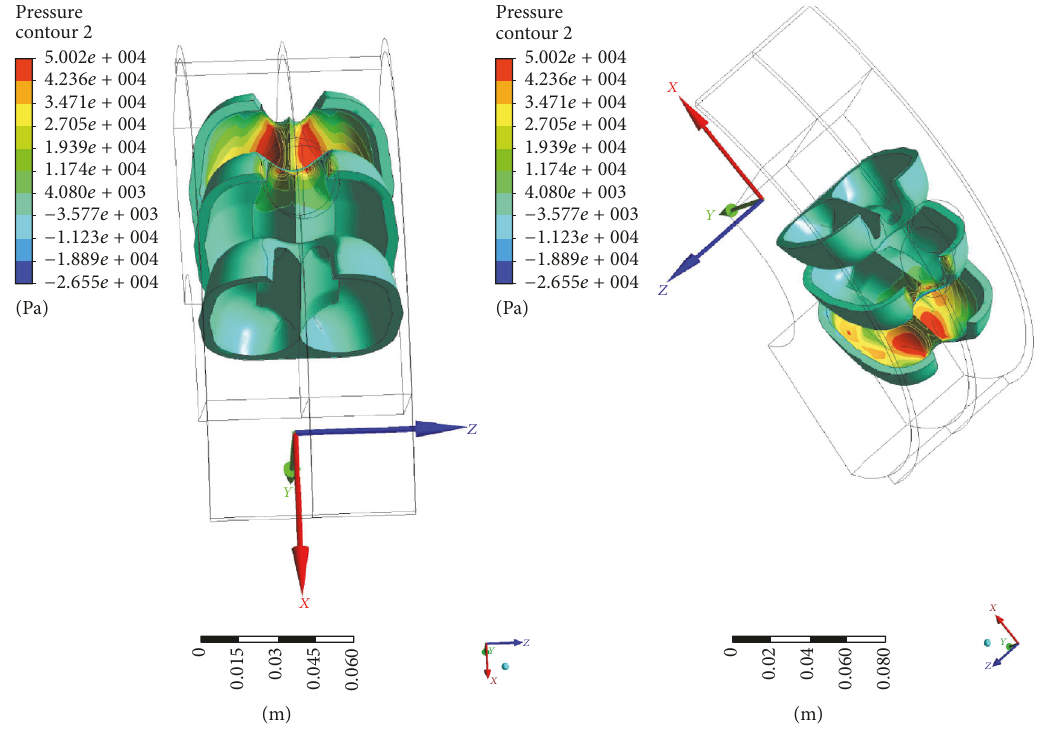
Figure 12: Pressure contours on the bucket (PCD = 500